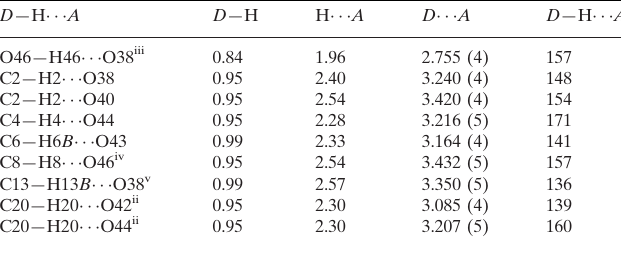
Hydrogen-bond geometry (A˚ , (cid:3)